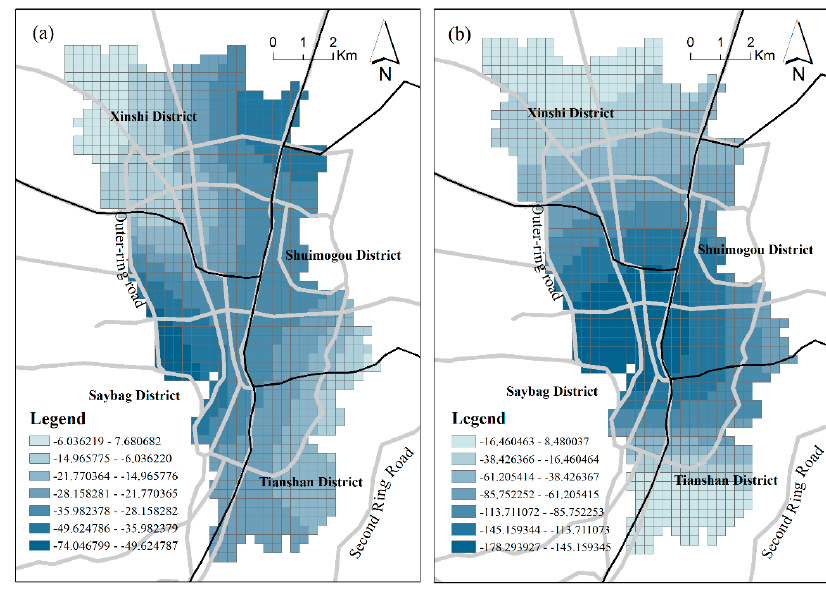
Figure 7. The coefficient of Mdis_NCC : ( a ) Model 1; ( b ) Model 2.